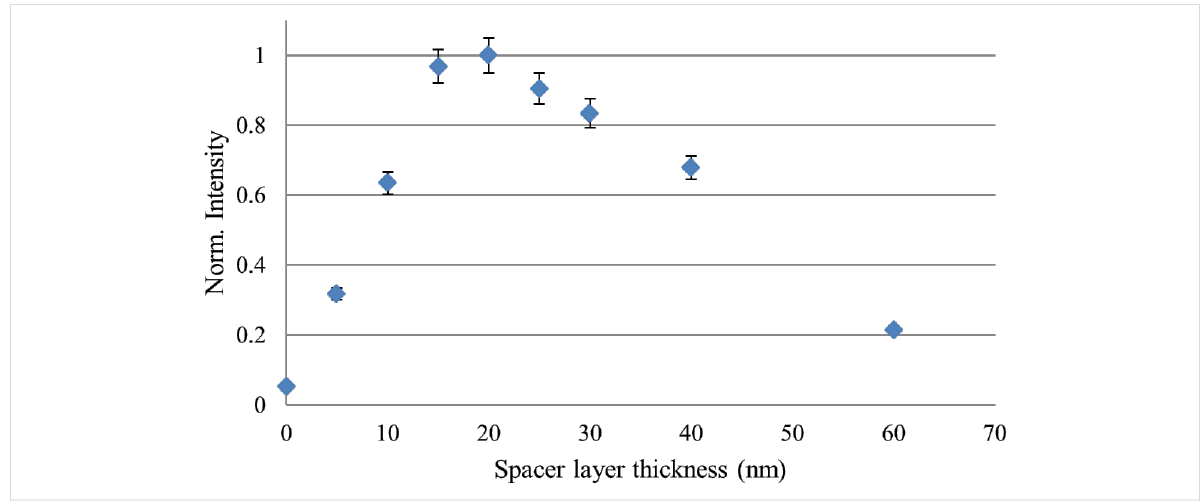
Figure 8: Normalised intensity at the outcoupling end of 20 µm stripe against spacer layer thickness.